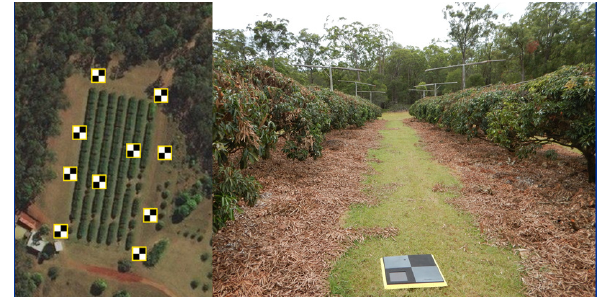
Figure 2. Distribution and field photo of AeroPoints used for geometric correction of the RPAS imagery.